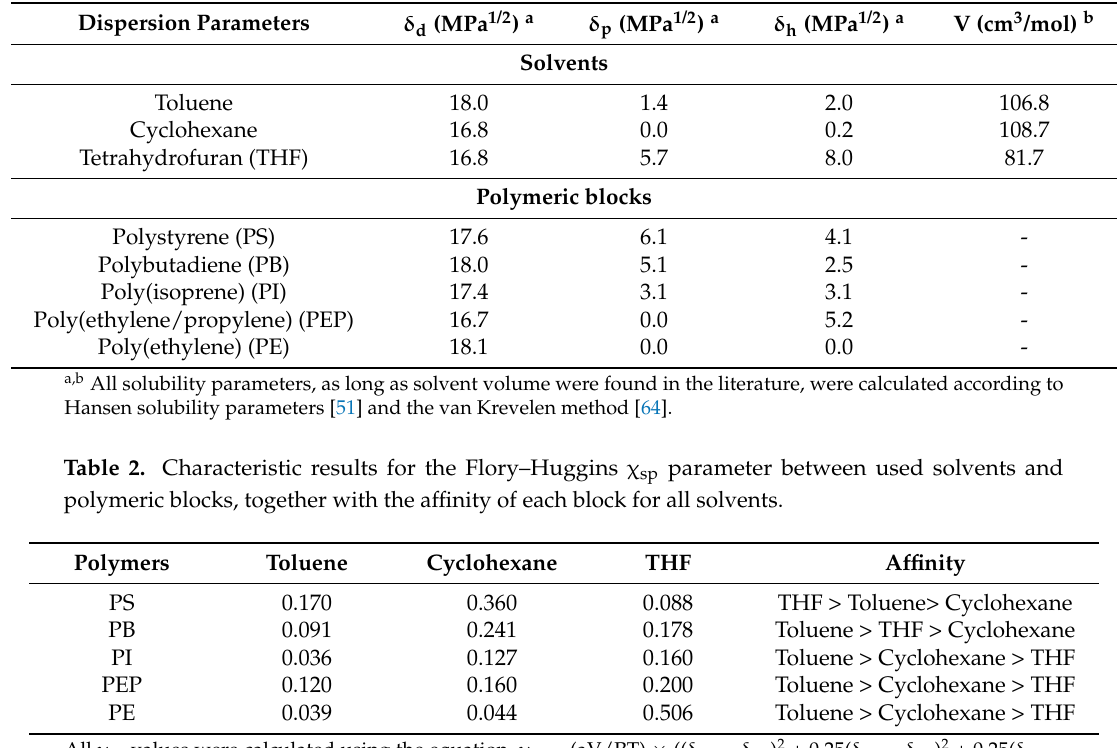
Table 1. Characteristic dispersion solubility ( δ d ), dipole solubility ( δ p ) and hydrogen-bond solubility ( δ h ) parameters, for all solvents and polymeric blocks.